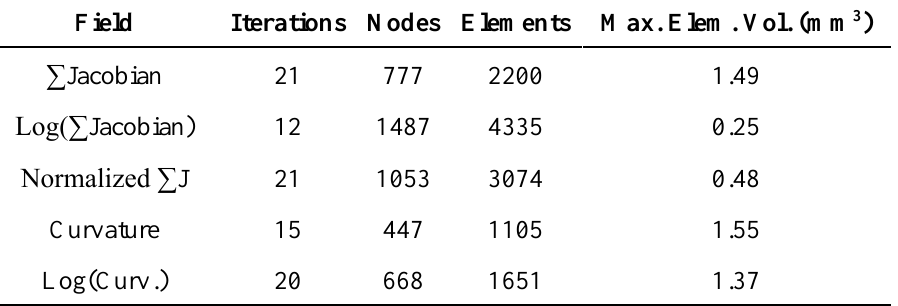
Table 2. Mesh characteristics at convergence under different solution